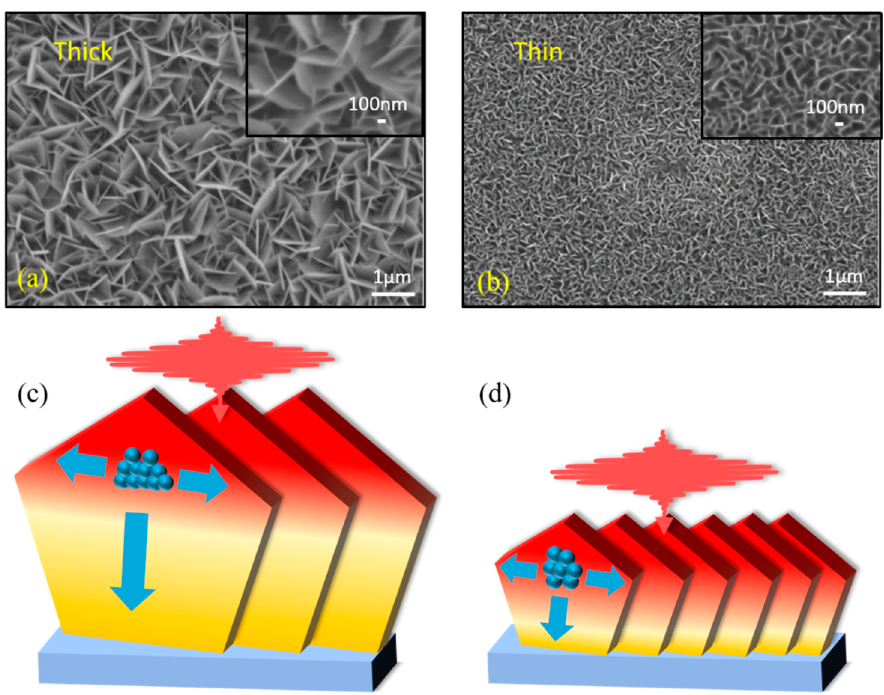
Figure 2. Top-view SEM images of the thick ( a ) and thin ( b ) SnS 2 film, respectively. The schematic diagram of the sample photoexcited by the pump pulse and the photocarrier trapping in thick ( c ) and thin ( d ) SnS 2 nanoflakes.